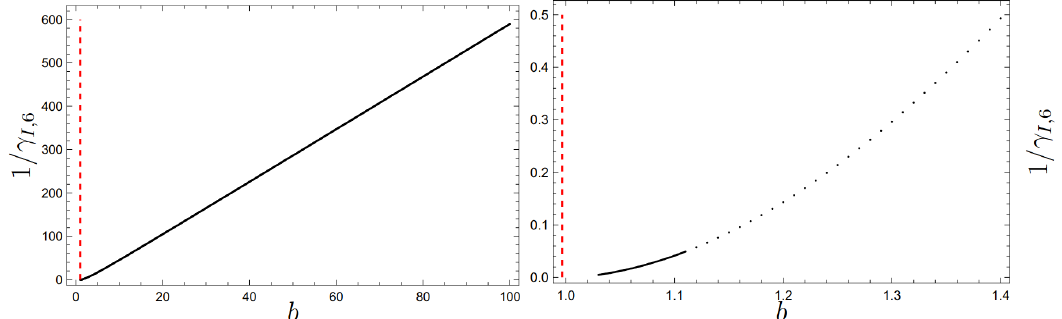
Figure 10 . Thermal conformal order parameter γ 6 ≡ T − 6 hO 6 i of the deformed Model III diverges as b → b + 0 , represented by the dashed vertical red line. crit ,III